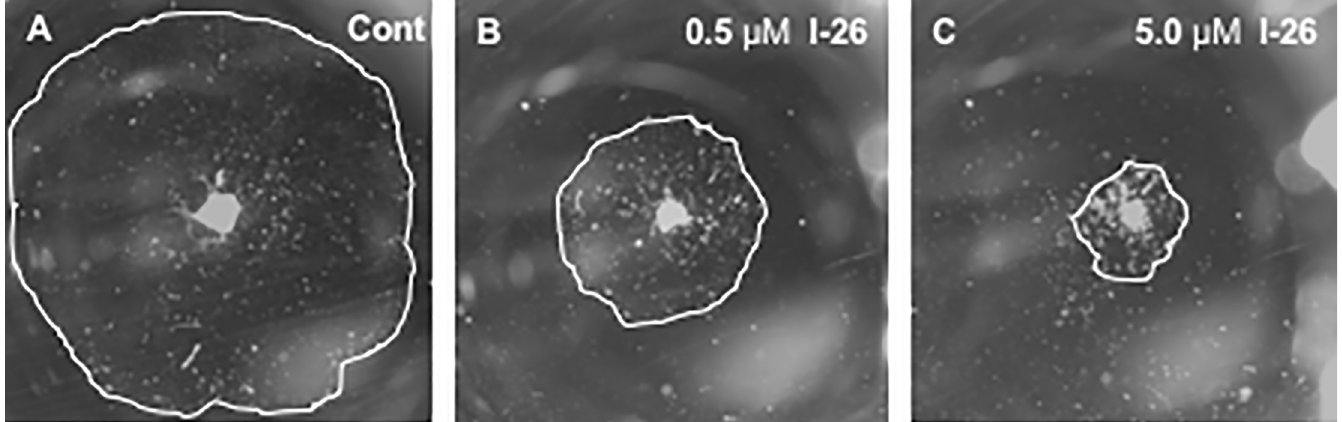
Fig 2. ME mucosal explant cultures. Representative examples of mucosal explants from the MEs of rats. The figure illustrates the growth of explants from rat MEs after 9 days in vitro (DIV). A. Negative control explant (not treated with any inhibitor) exposed only to DMSO (Control). B. Explant treated with 0.5 μ M Library I compound 26, an EGFR inhibitor, from day 3 to day 9. C. Explant treated with or 5.0 μ M Library I compound 26. The white line tracks the edge of each explant, and defines the explant area.